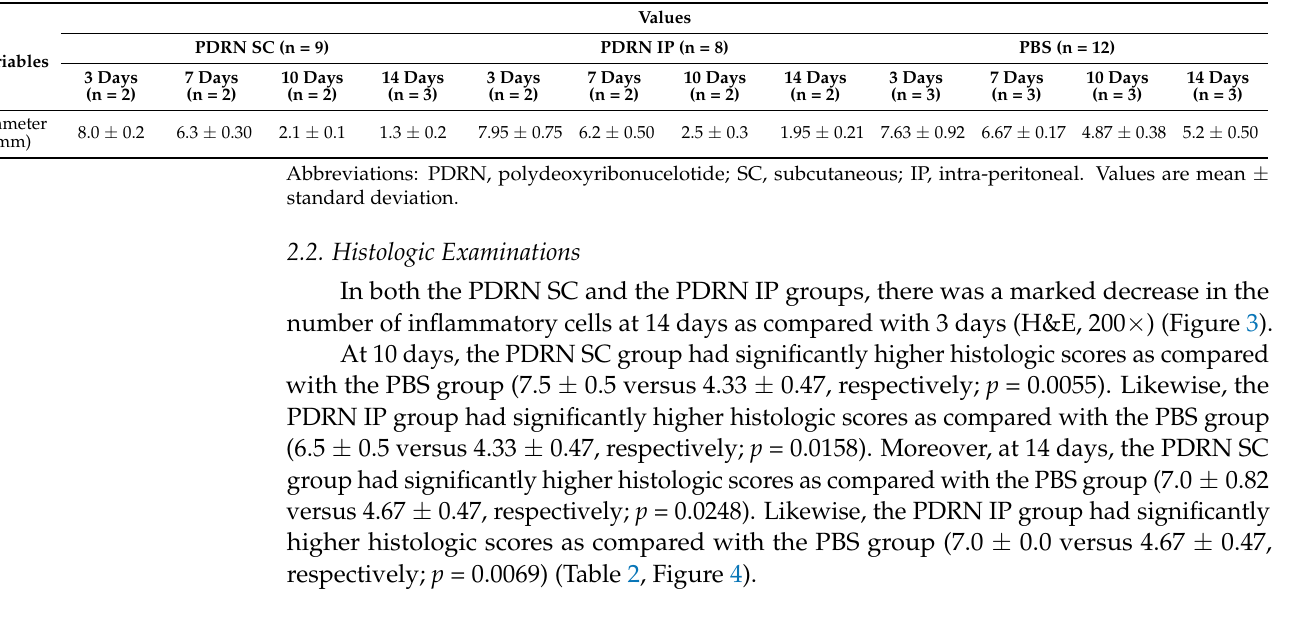
Table 2. Histologic scores.